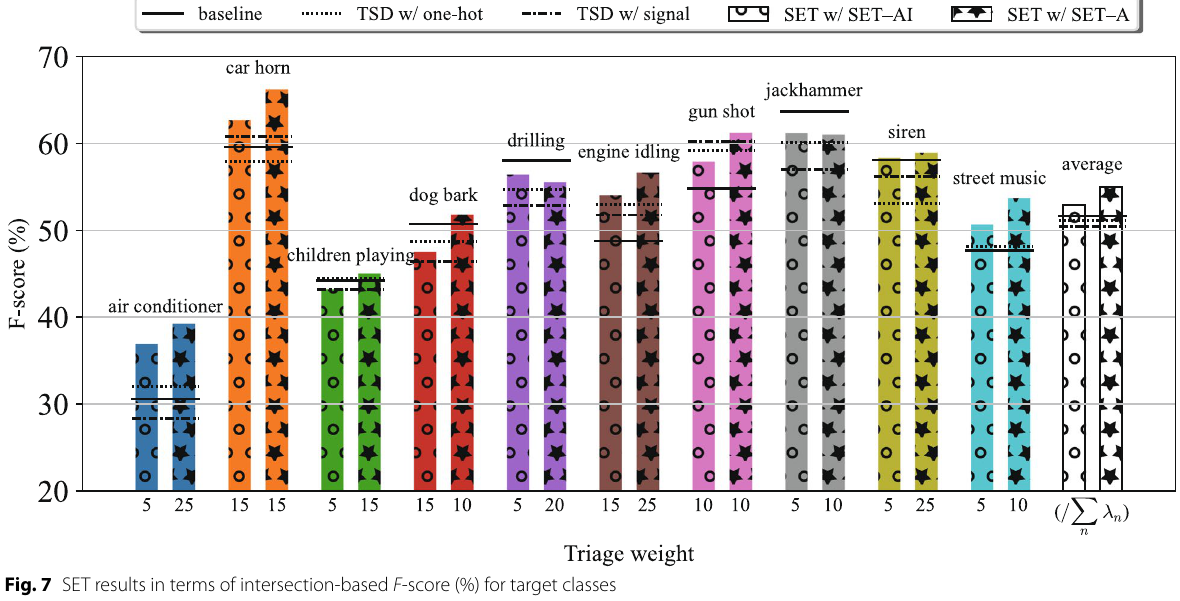
Fig. 7 SET results in terms of intersection-based F -score (%) for target